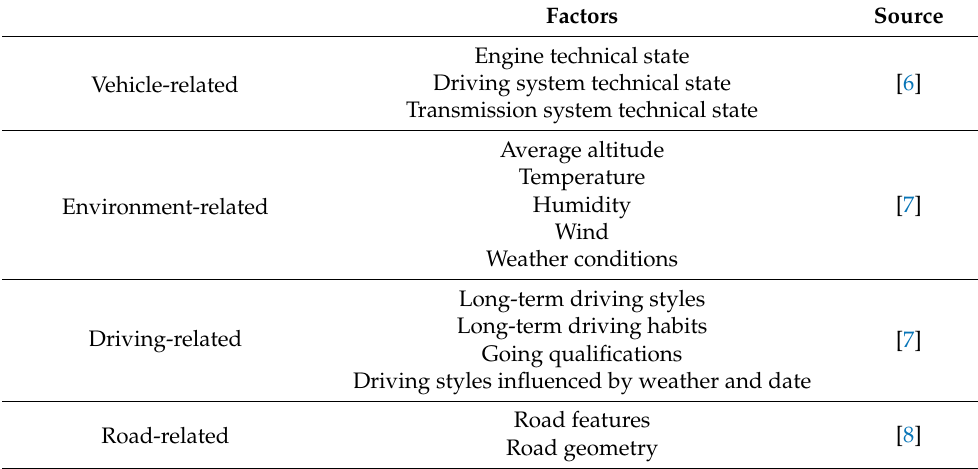
Table 1. The categories of influencing